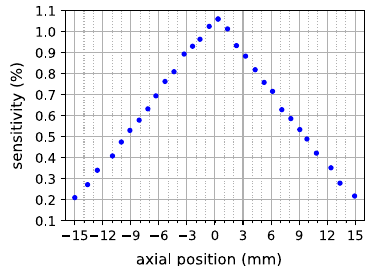
Fig. 2 Sensitivity at different axial positions for the energy window of 391–601 keV.